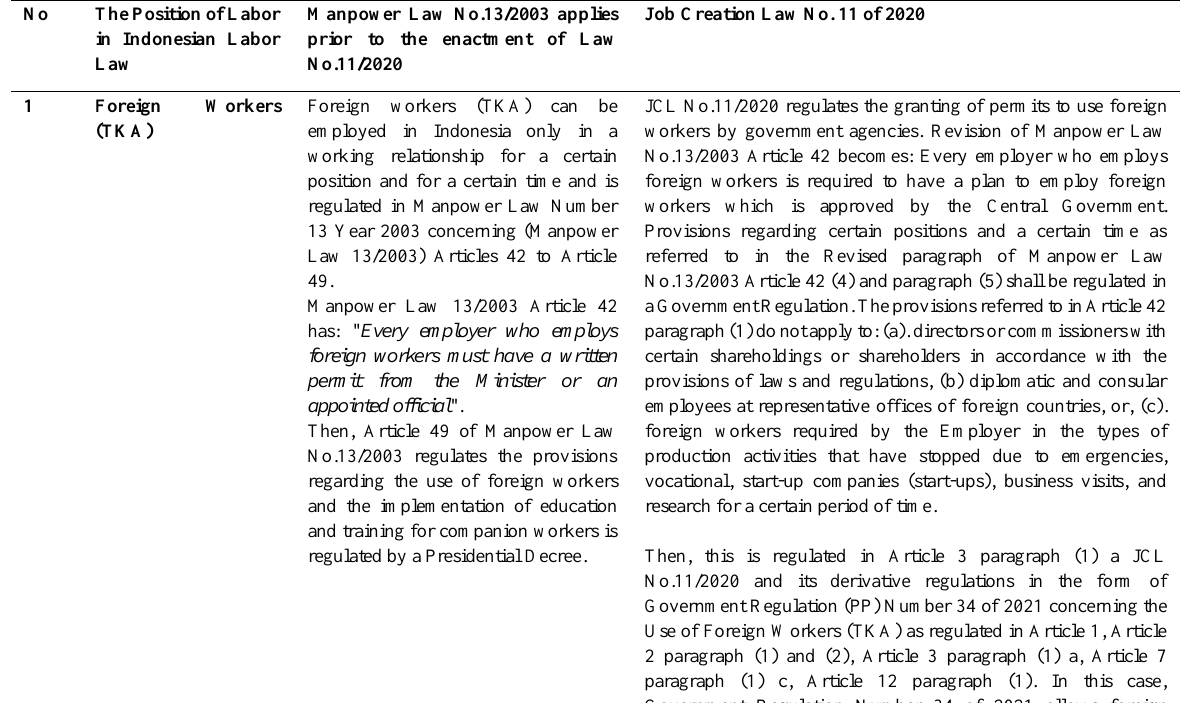
Table 1: The Position of Labor in Indonesian Labor